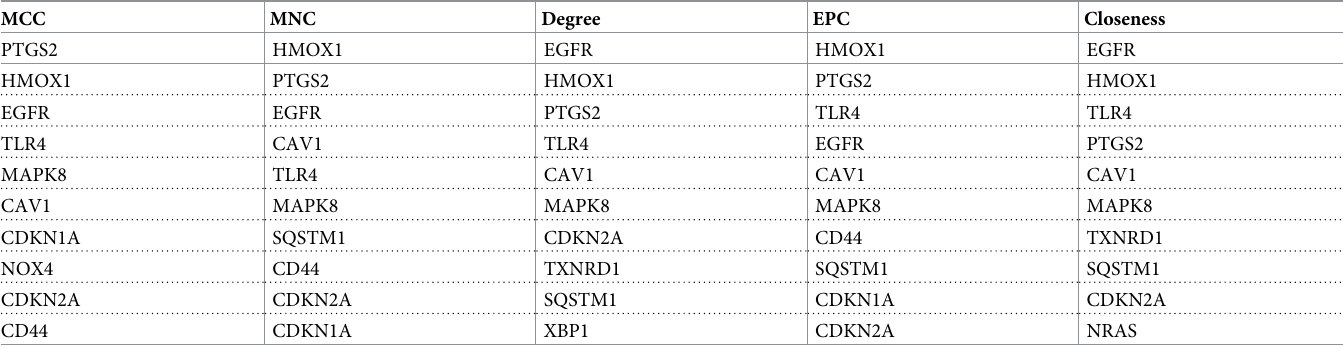
Table 2. Top ten hub genes obtained by five algorithms of